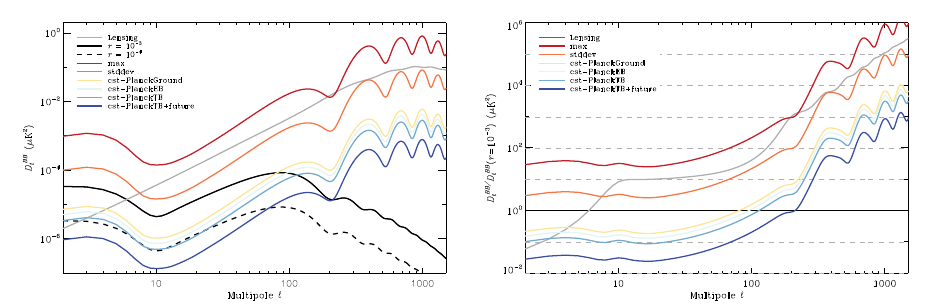
(cid:31) ( (cid:31) + 1) / (2 π ) ∆ C BB Figure 1. Left panel : ∆ D BB E - B mixing due to the mis-calibration (cid:31) ≡ (cid:31) power spectrum bias from · of the absolute polarisation angle. This bias is plotted for the di ff erent absolute calibration errors ∆ ψ presented in Sect. 3 (from red to blue, see legend). The Λ CDM best fit D BB (cid:31) primordial tensor model for r = 10 − 3 and r = 10 − 4 (solid and dashed black lines, respectively) and D BB (cid:31) lensing model (gray line) are also displayed. Right panel : Same as left panel, but relative to the primordial tensor model for r = 10 − 3 .